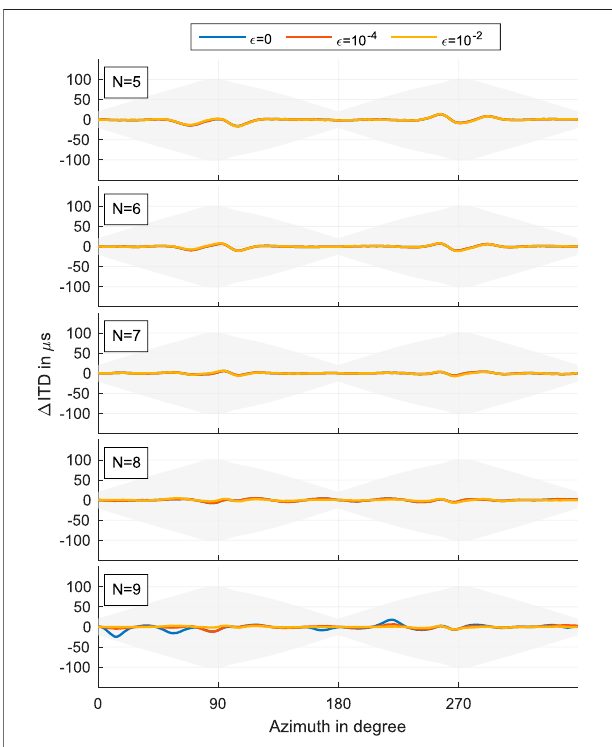
FIGURE 4 | Difference in horizontal plane ITD relative to the dense reference for grid Irregular 6 at selected SH orders and regularization values ϵ . The shaded area denotes the JND as a function of the reference ITD. HRTF: Subject no. 10 from HUTUBS database.